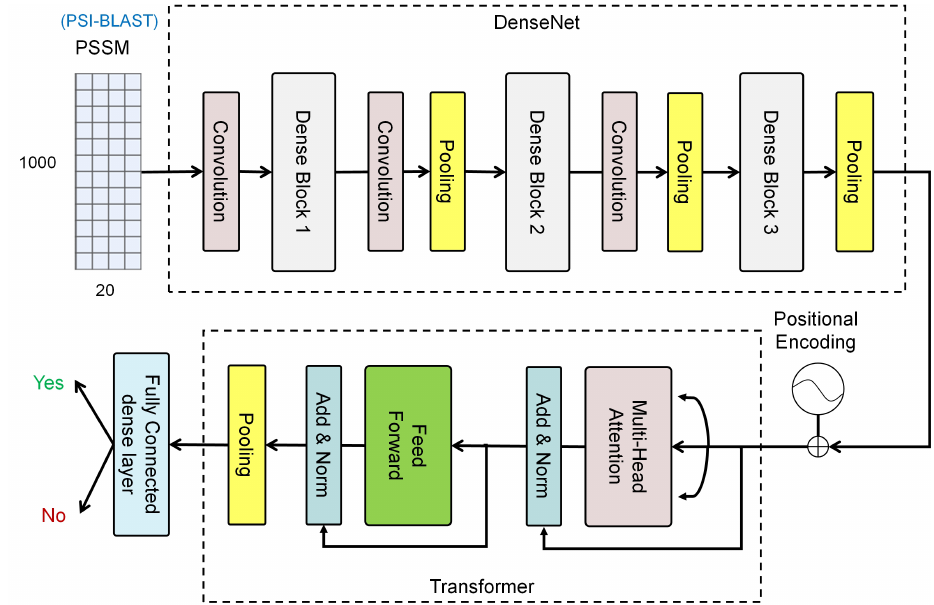
Figure 1. The architecture of DenSec which supports input as PSSM of protein sequences, feature extraction through DenseNet, classification based on Transformer with fully connected dense layer, and the outputs as the probability of being secreted protein in